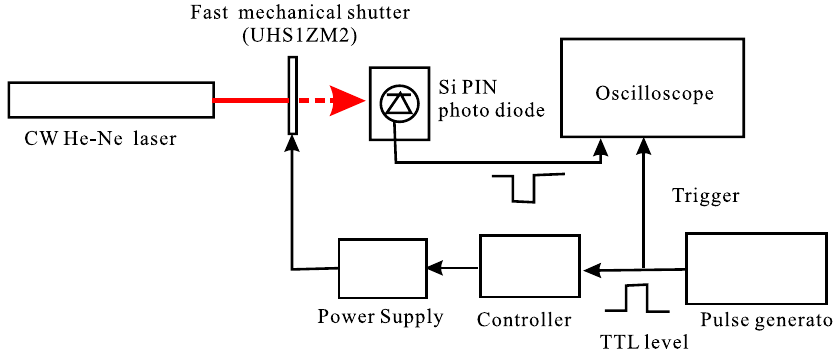
FIG. 7. (Color) Setup of a performance test of the fast mechanical shutter on a test bench.